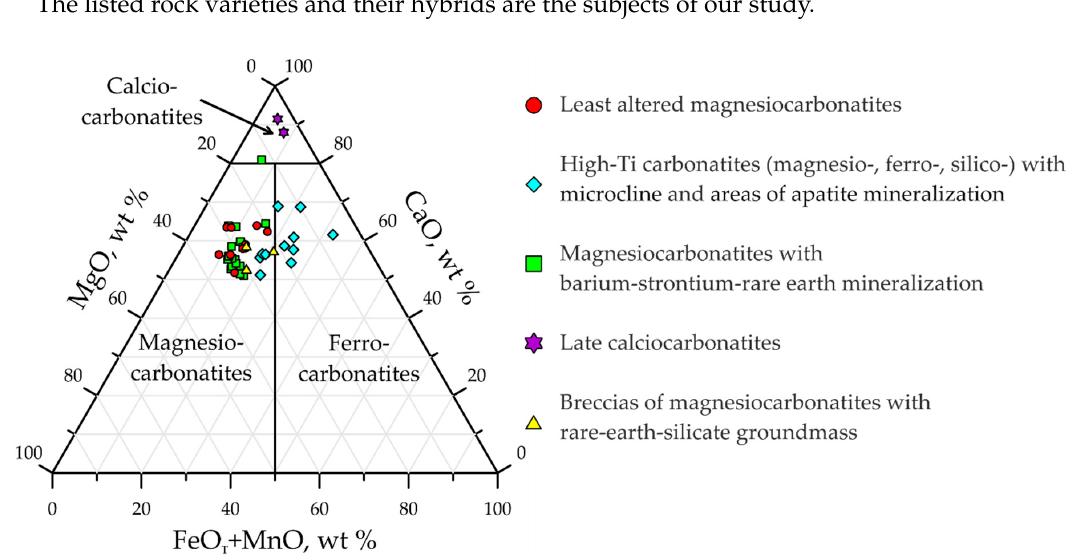
Figure 2. Composition points of the Petyayan-Vara carbonatites on the CaO–MgO–(FeO + MnO) (wt. %) classification diagrams from [3,86].